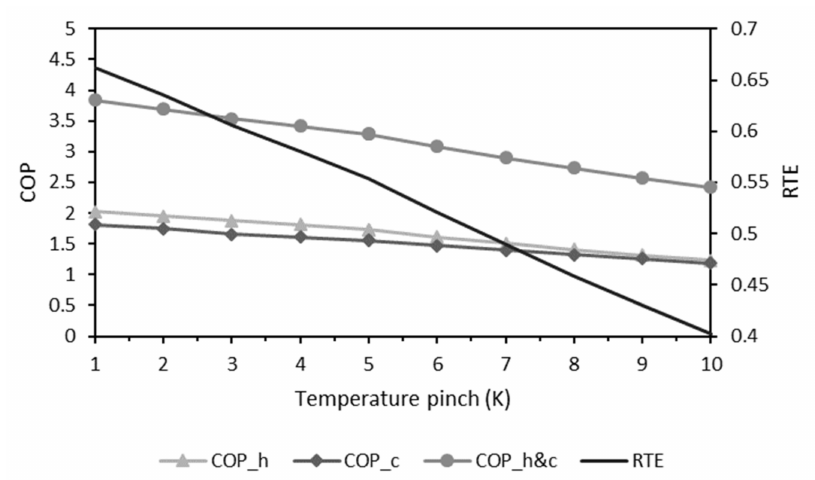
Figure 6. Evolutions of COP depending on high pressure.